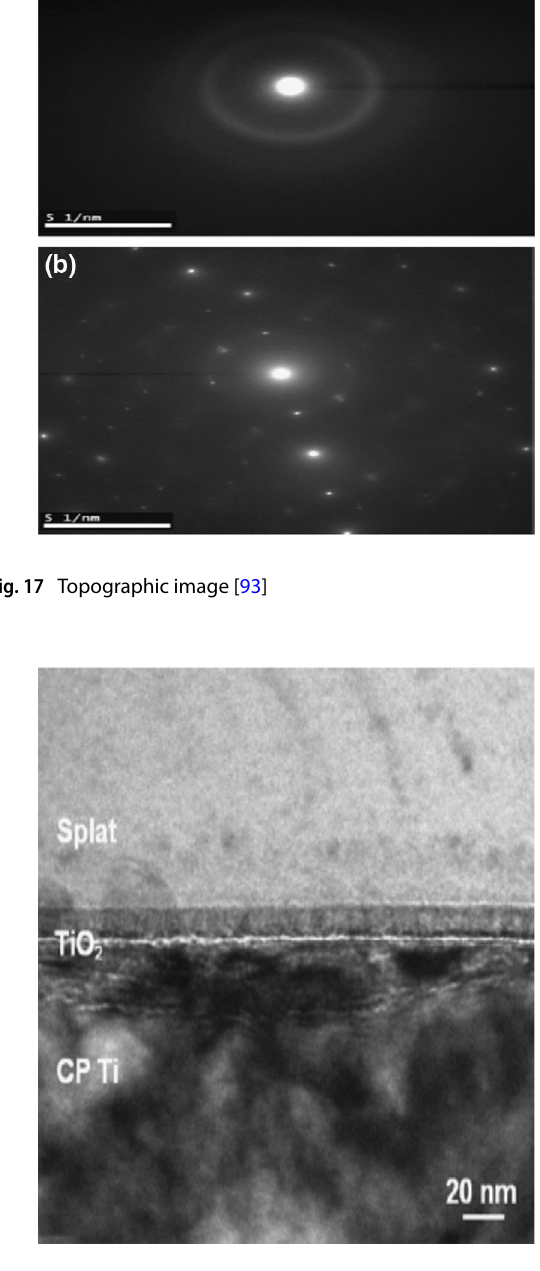
Fig. 18 Diffraction patterns (TEM) a a typical amorphous structure b re-crystallization stage